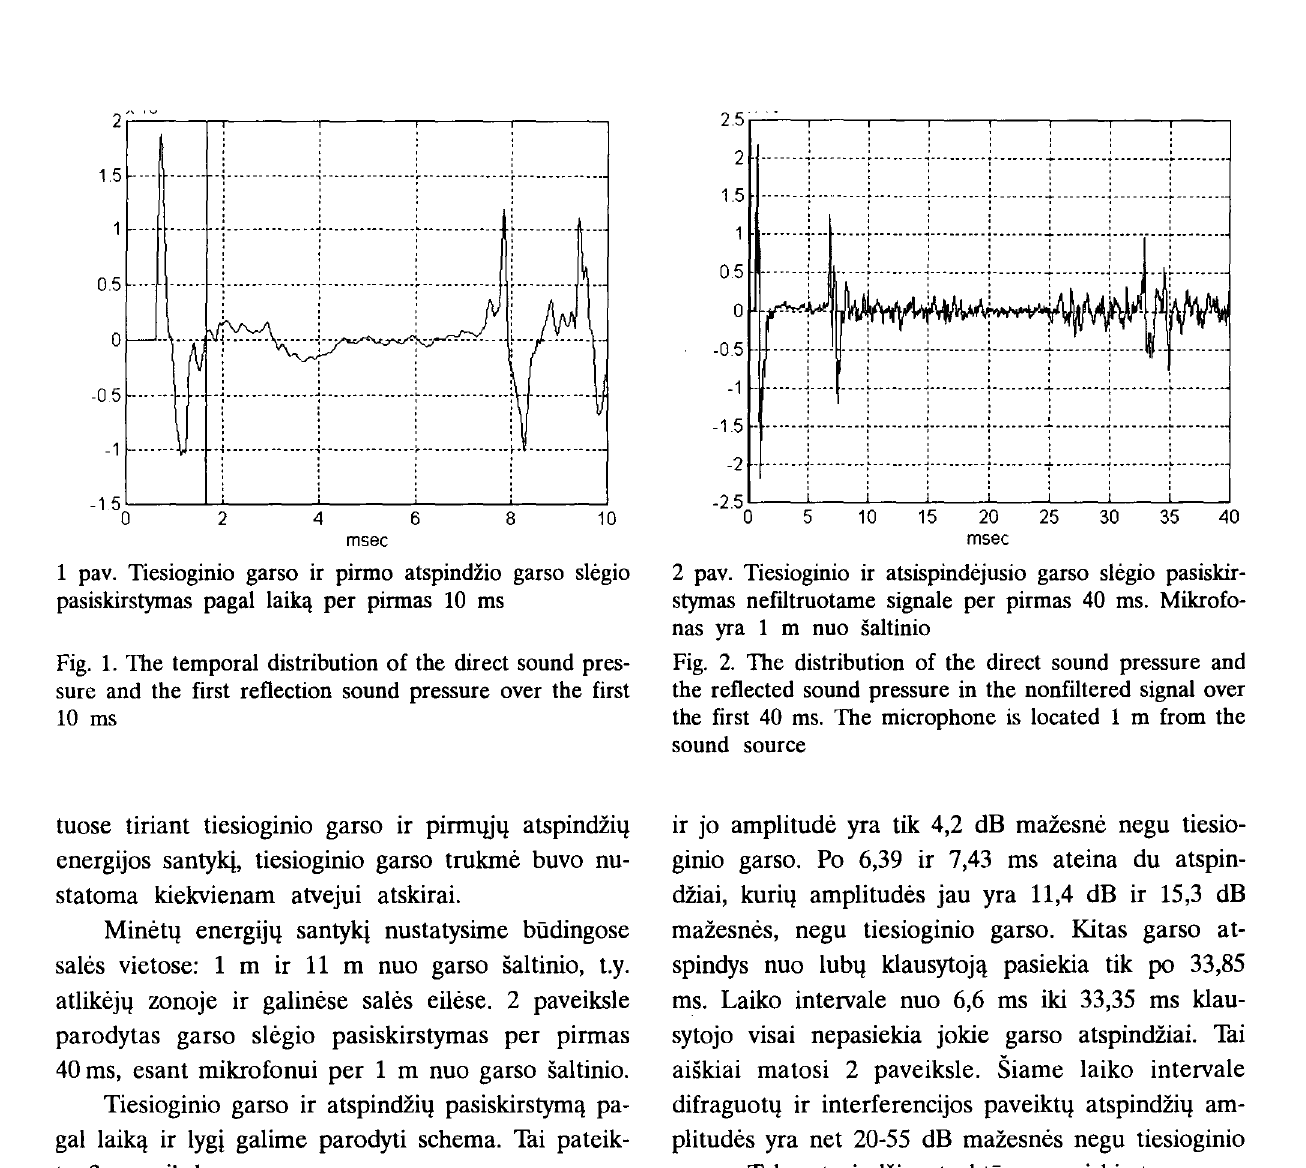
Fig. 3. The diagram of the distribution of the direct sound and reflections by time and level. The microphone is lo cated 1 m from the sound